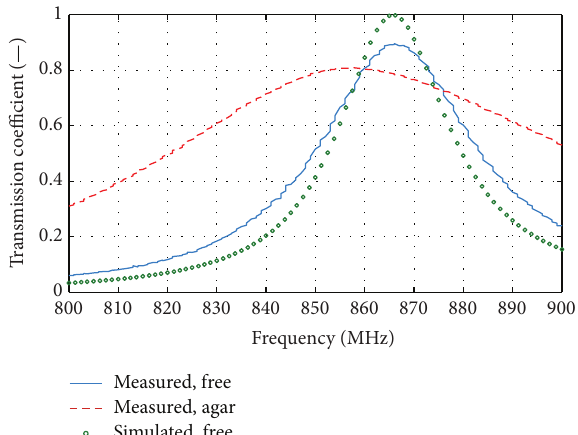
Figure 4: Simulation and measurement of the transmission coeffi- cient of the vertically folded coupled patches tag antenna.